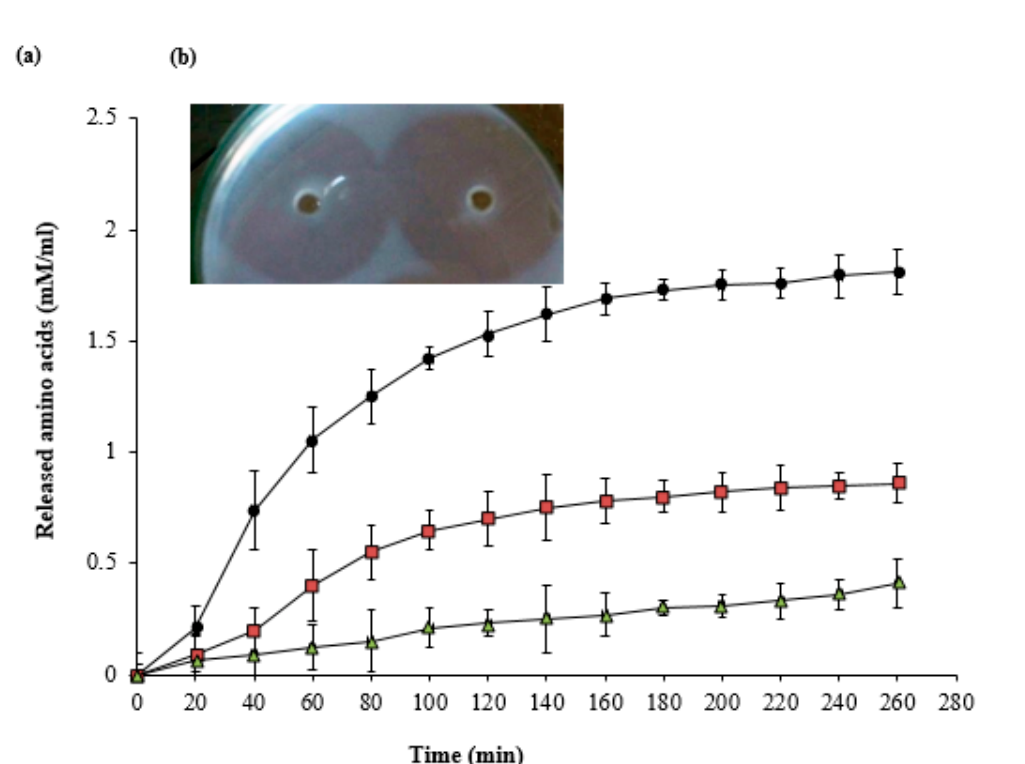
Figure 2. ( a ) Analysis of substrate specificity of the tested bacterial protease against the proteinaceous components of eschars (fibrin, native collagen, and denatured collagen). ( b ) Fibrin plate assay; left well contains 0.5 µg enzyme only per well (plasminogen-free well), but right well contains 0.5 µg enzyme and 10 mU plasminogen (plasminogen-rich well). The plate was incubated at 37 °C for 12 h.